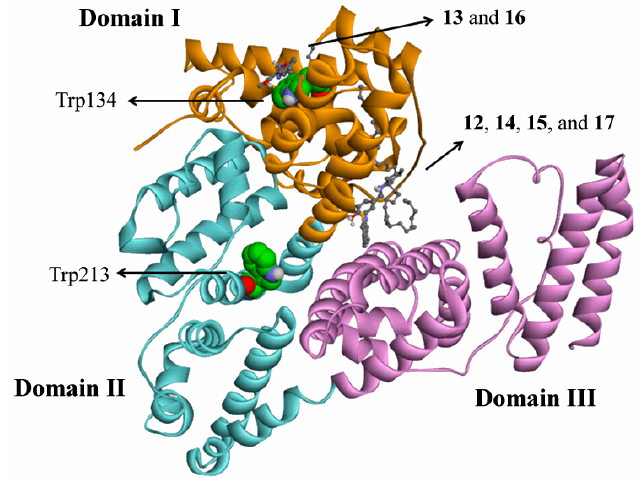
Figure 8. Binding sites of the ESIPT lipophilic benzazoles 12 – 17 predicted by semi-flexible docking. Only compounds 13 and 16 interact directly with the Trp134 residue. The benzazoles are repre- sented by ball and stick models. The domain regions comprise the following: domain I (residues 1–195), domain II (residues 196–383), and domain III (residues 384–583) [62].